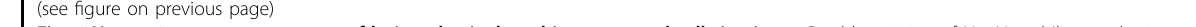
Fig. 6 Neurog2 converts astrocytes of lesioned spinal cord into neuronal cells in vivo. a Double staining of NeuN and Iba1 on horizontal sections of the lesioned spinal cord at 14 DPL. Iba1 acts as microglia marker and represents the intensity of the immune response. b Double staining of GFAP and MAP2 on horizontal sections of the lesioned spinal cord at 14 DPL. MAP2 and GFAP indicate neuronal fi bers and astrocytes, respectively. m, o, x, z regions in ( a , b ) denote neuron-lost areas adjacent to lesion sites (n, y). c – d ″″ Horizontal images of the lesioned spinal cord shown double staining of mCherry and NeuN on slices from mice infected with the control virus AAV – mCherry ( c – c ″″ ) or AAV-Neurog2/mCherry ( d – d ″″ ) on day